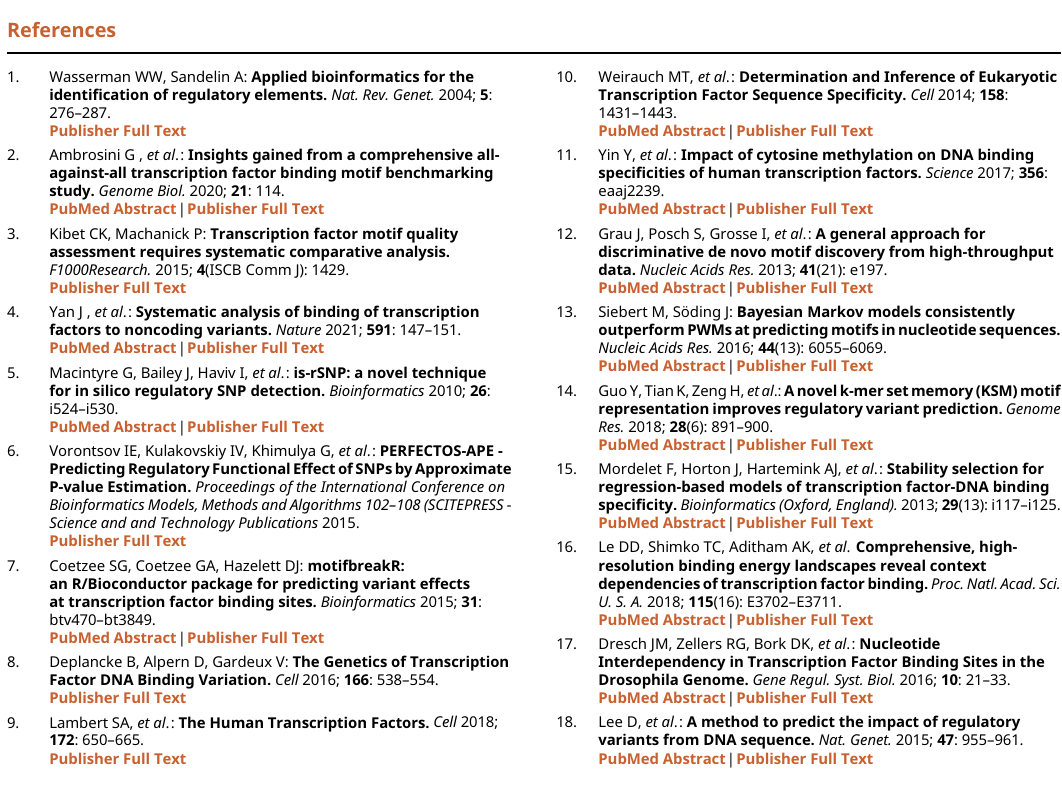
(cid:129) Supplementary table S1 (Overview of PWMs and their performance in recognizing SNPs affecting transcrip- tion factor binding in SNP-SELEX data.)